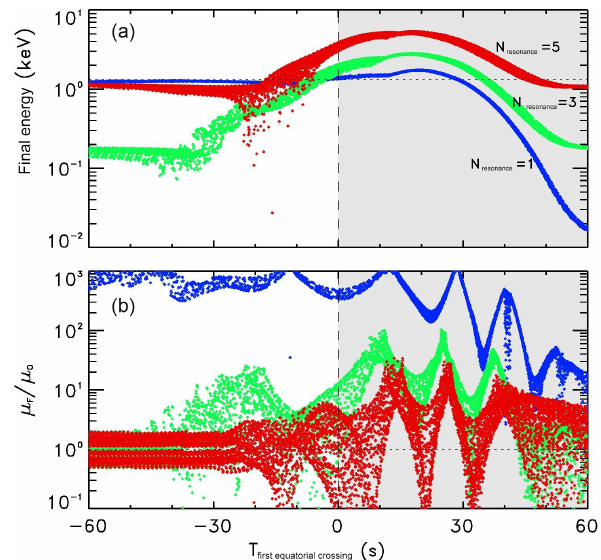
Figure 6. Final H + energy (top) and magnetic moment (bottom) as a function of the first equatorial crossing time. Different initial energies are considered ( N = 1, N = 3, and N = 5 in Eq. (2), coded in blue, green, and red, respectively). A 60s (shaded area) magnetic transition is